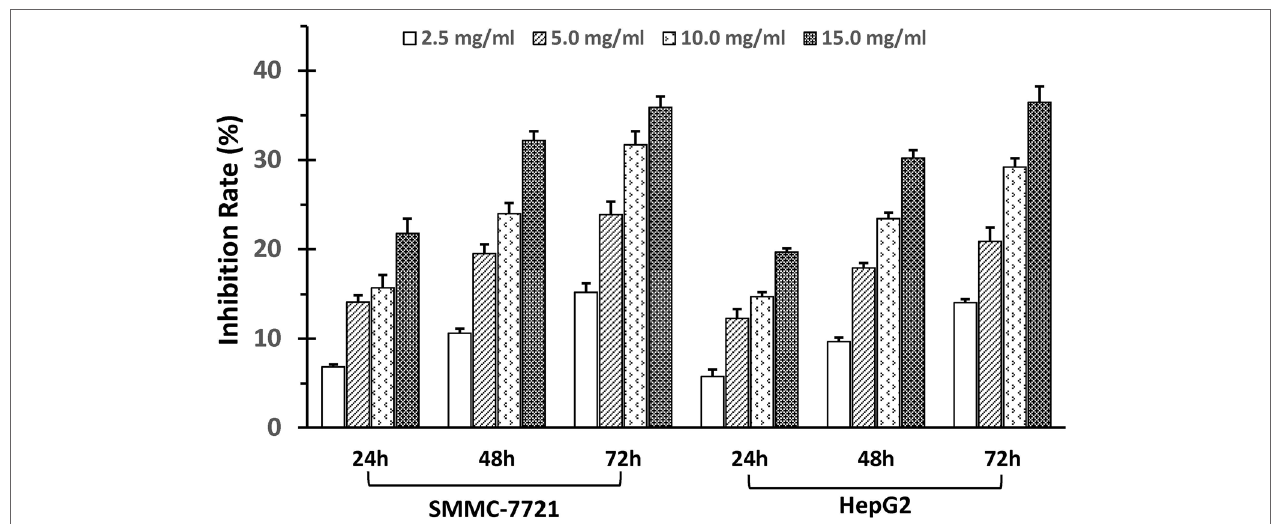
FIGURE 1 | SSd inhibited proliferation of SMMC-7721 and HepG2 cells. Adherent liver cancer cells (SMMC-7721 and HepH2) were seeded in 96-well plates (5 × 10 3 cells/well) and incubated with different concentrations of SSd ranging from 2.5 to 15 µg/ml, and time intervals ranging from 24 to 72 h, as indicated on the histograms. Cell proliferation was determined by the MTT assay. Data were expressed as mean ±